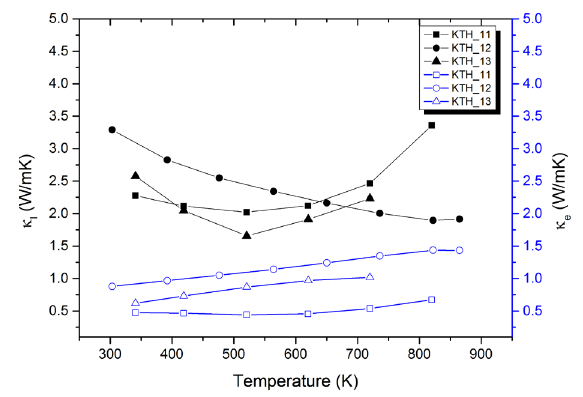
) (hollow symbols) and lattice thermal ( k e